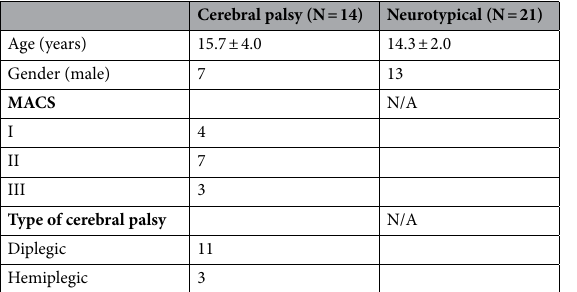
Table 1. Participant demographics. Participant demographics are displayed for the group with CP and the NT group. Abbreviations: manual ability classification system